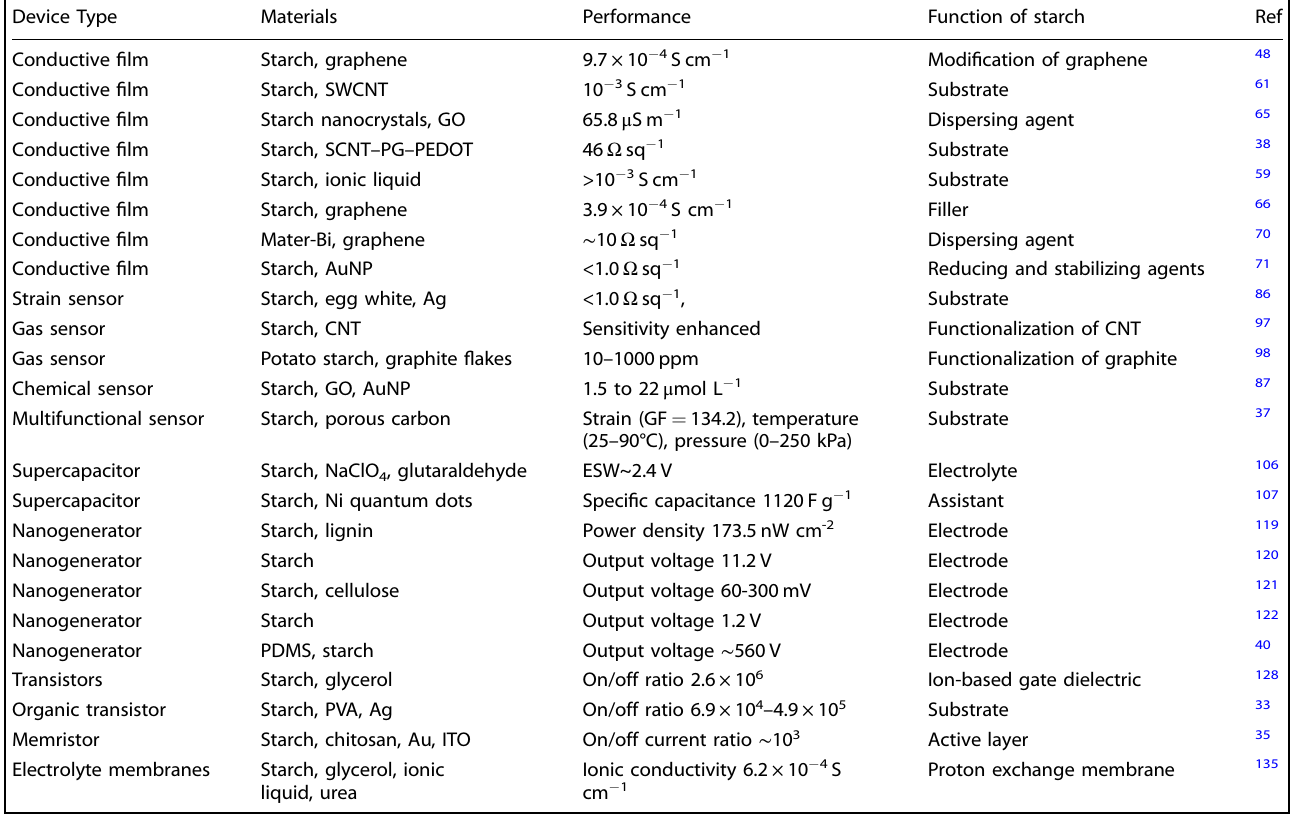
Table 1. Summary of FEs based on starch fi